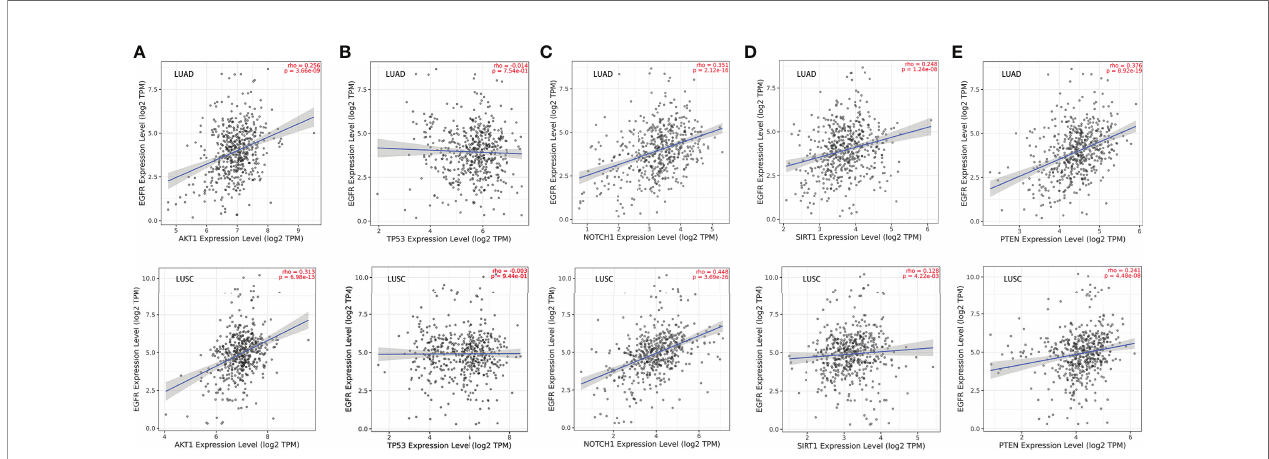
FIGURE 4 | Correlations between EGFR and the 5 core target genes in LUAD and LUSC were studied using TIMER 2.0 database. (A) AKT1-EGFR. (B) TP53- EGFR. (C) NOTCH1-EGFR. (D) SIRT1-EGFR. (E) PTEN-